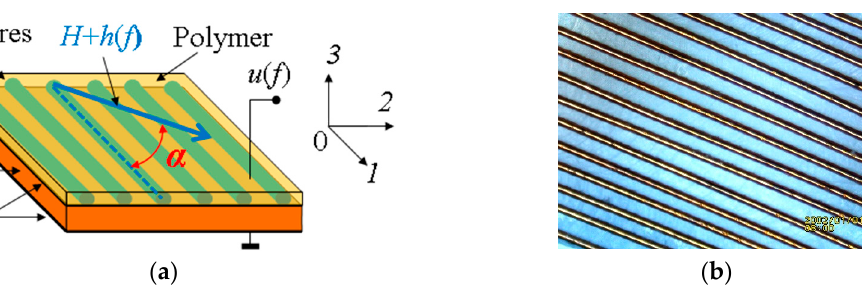
Figure 1. ( a ) Schematic representation of the magnetostrictive fibrous composite-piezoelectric (MFC-